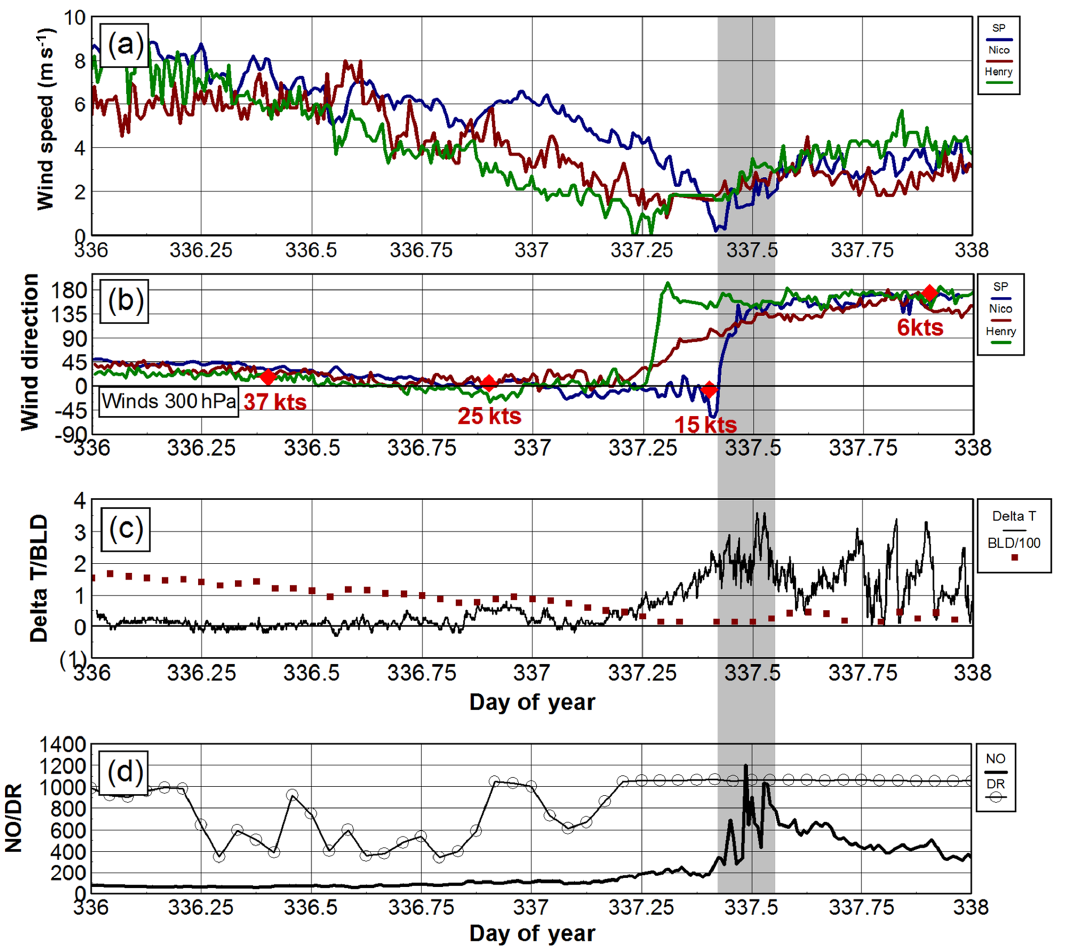
Figure 8. Time series of (a) wind speed, (b) direction (c) (cid:49)T and BLD and (d) NO and direct radiance (DR) for Days 336–338, 2006 (Case C in Fig. 7). In (b) we indicate wind speed and direction at 300hPa (red diamonds) at the actual launch times of the rawinsondes (generally 2–3h prior to reporting times of 00Z and 12Z). Of note is the decrease in surface wind speeds from over 8ms − 1 (sufficient for blowing snow) that follow the same trend as at 300hPa. We have also indicated the BLD calculated later in Appendix A that shows the rapid decrease in